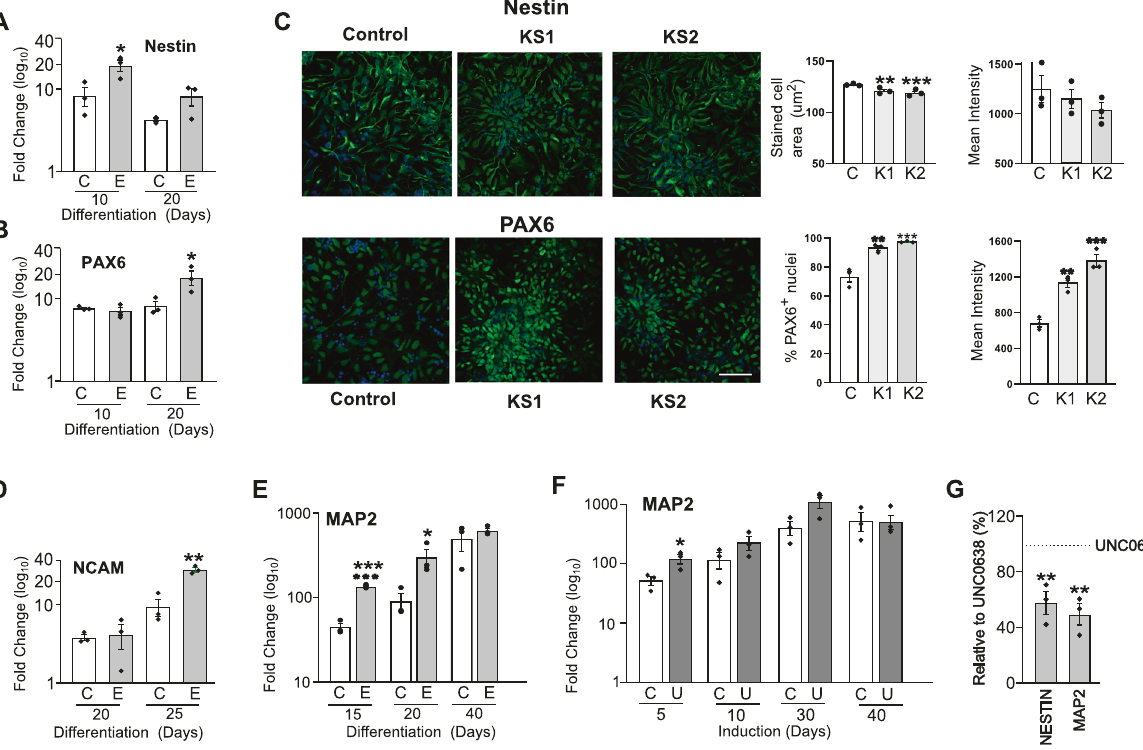
Fig. 4 Reduced EHMT1 activity results in accelerated neuronal development. qRT-PCR analysis at days 10 and 20 of differentiation to examine the expression of the neural progenitor markers, ( A ) Nestin and ( B ) PAX6 in EHMT1 − / + -derived NPC relative to expression in the isogenic control. C Cell staining of two KS patient iPSC developed to NPC (Day 20) stage and stained for Nestin and PAX6 protein. Scale Bar, 50 μ m. Graphs show quantitation of protein expression as: stained cell area (Nestin); stained (PAX6 + ) and mean fl uorescence intensity, with DAPI nuclear counterstain. D qRT-PCR analysis of NCAM at days 20 and 25 of early stage differentiated neurons in EHMT1 − / + -derived relative to expression in the isogenic control. E qRT-PCR analysis at days 15, 20 and 40 of differentiation to examine changes in the expression of the neuronal marker MAP2 in EHMT1 − / + -derived neurons relative to their expression in the isogenic control neurons. F UNC0638 (250 nM) induced expression of MAP2 in differentiating wild-type hiPSC-derived neurons, monitored by qRT-PCR analysis over a time course of 5, 10, 30 and 40 days of treatment. G Relative mRNA abundance measured by qRT-PCR of Nestin and MAP2 in wild-type hiPSC treated with UNC0638. Induction of REST Δ UTR with doxycycline (DOX) suppresses the UNC0638-induced MASH1 gene expression. n ≥ 3 independent experiments. Data were presented as Mean±SEM and analysed by One-way ANOVA with post hoc comparisons using Dunnett ’ s multiple comparisons test comparing to control samples.